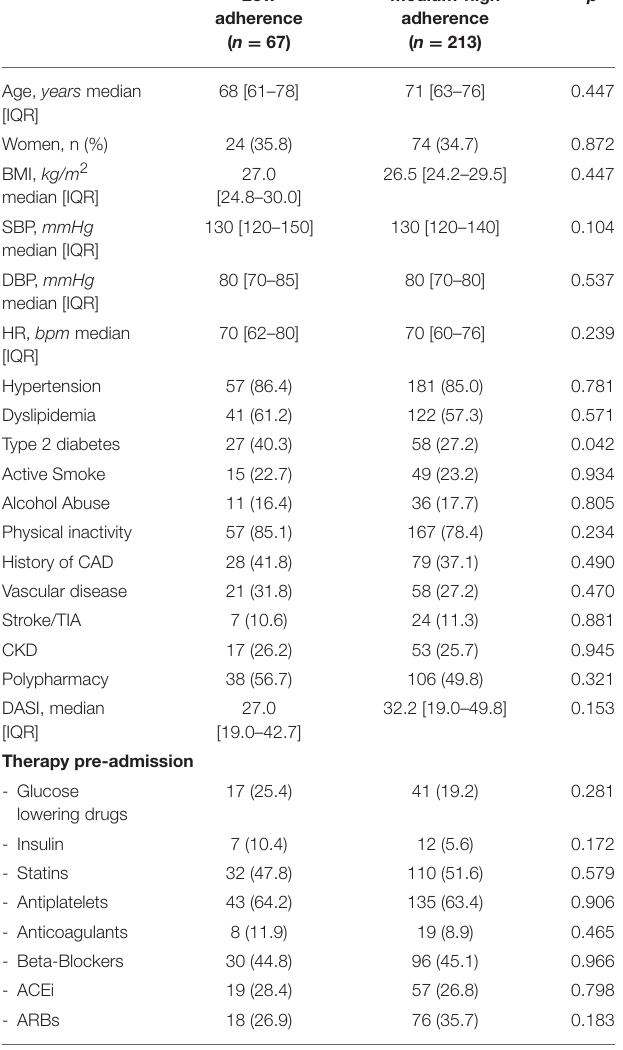
TABLE 1 | Baseline clinical characteristics of EVA patients according to pre-admission medication adherence.